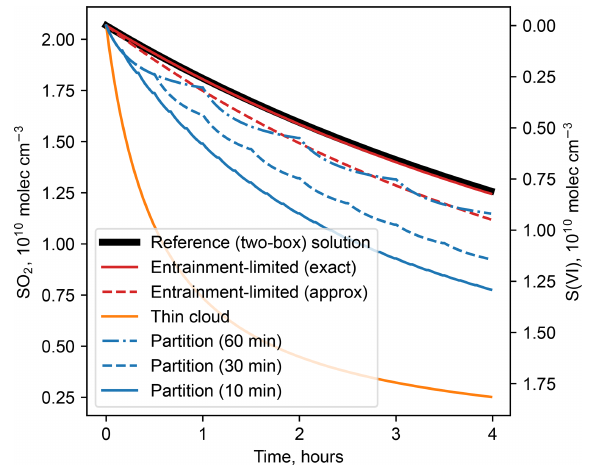
Figure 1. Comparison of numerical solutions for reaction of dis- solved SO 2 with H 2 O 2 in cloud water in a partly cloudy re- gion. Calculations use the following conditions: T = 284K, p = 800hPa, 1gm − 3 liquid water in cloud, pH = 5, f c = 0 . 2, k c = 1h − 1 , k eff = 3 . 7 × 10 − 14 cm 3 molec. − 1 s − 1 , and initial concentra- = c = 2 . 0 × 10 10 molec.cm − 3 (1ppb). For the cloud tions c SO H 2 O 2 2 partitioning method, the numbers in parentheses give the time step for homogenizing reactant